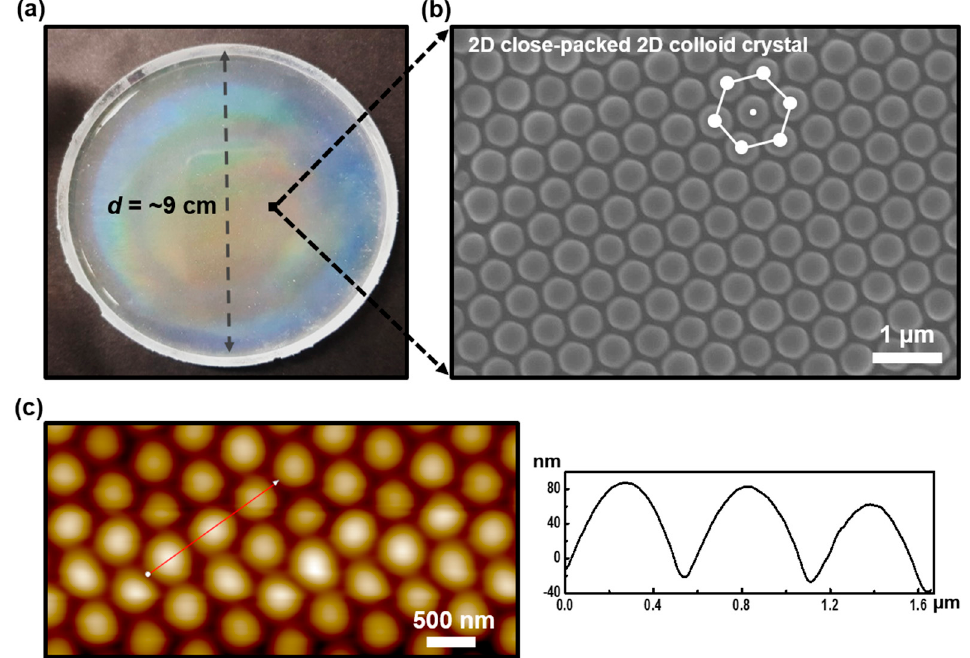
Figure 1. ( a ) Digital image of the monolayer 2D silica colloidal array film on a large scale, fabricated on the PDMS substrate by the directional rubbing method. ( b ) SEM and ( c ) AFM images of well-organized silica colloidal arrays with hexagonally ordered structures, and the height profile is presented besides the AFM image. The scale bar in ( b ) is 1 µm.